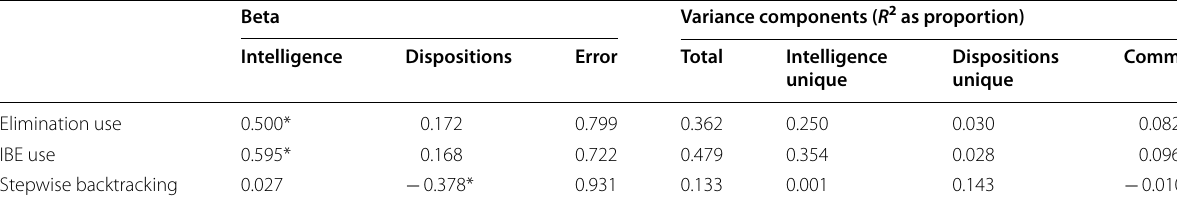
* p < 0.05 † Negative common variance may indicate slight suppression